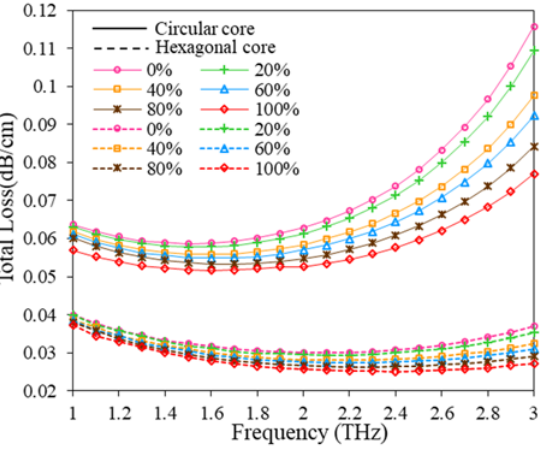
Figure 12. Total loss variation with the change of frequency for D = 643.34 μ m, D c = 280 μ m, t = 15 μ m, z = 10 μ m.